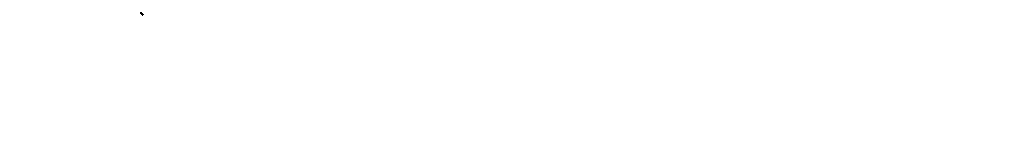
Tydskrif van die Suid-Afrikaanse Logopediese Vereniging, Vol. 17, Nr. 1: Des.